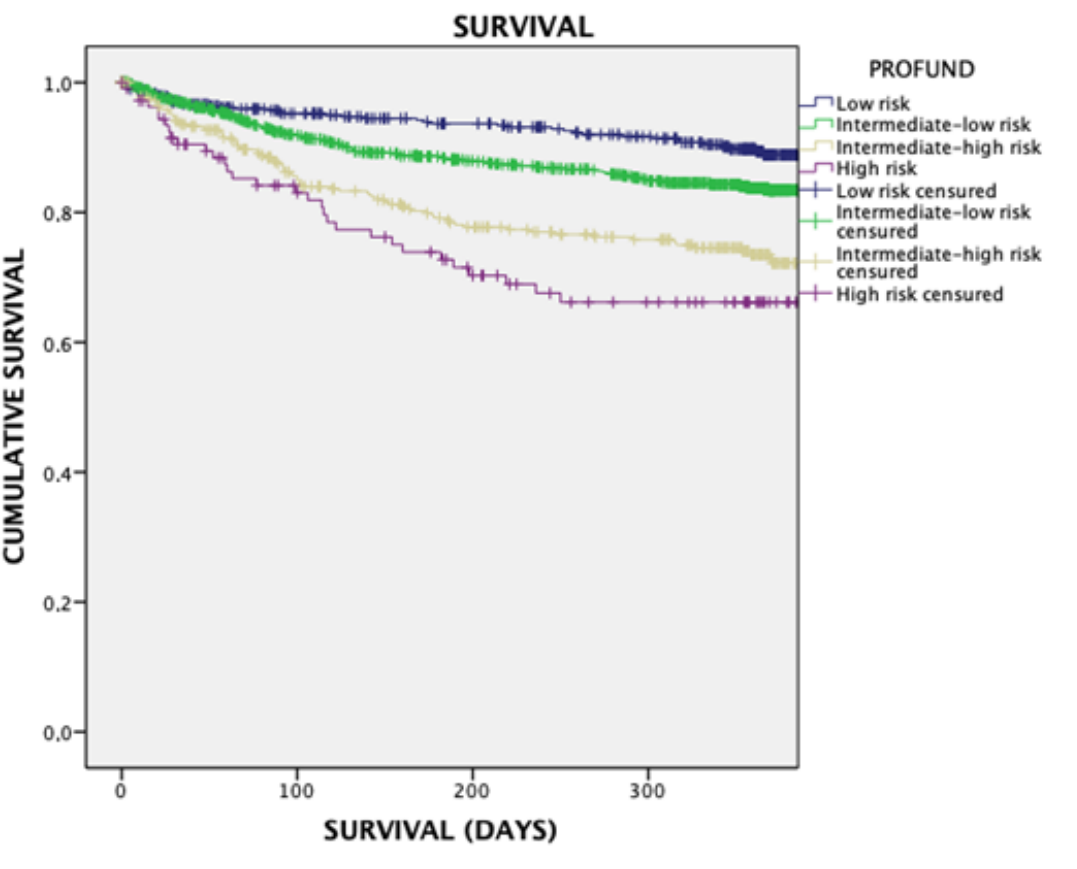
Figure 1. Kaplan-Meier curve for annual mortality in patients who have been classified by the PROFUND index.